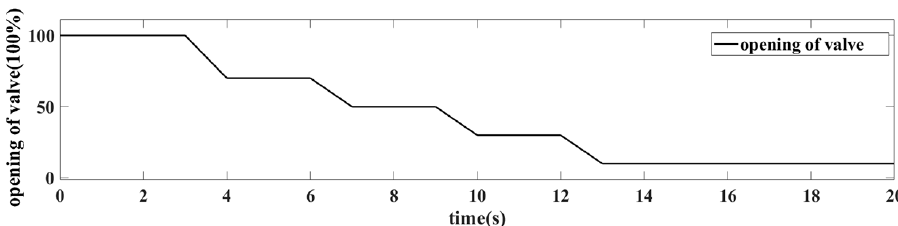
Figure 10. Opening of